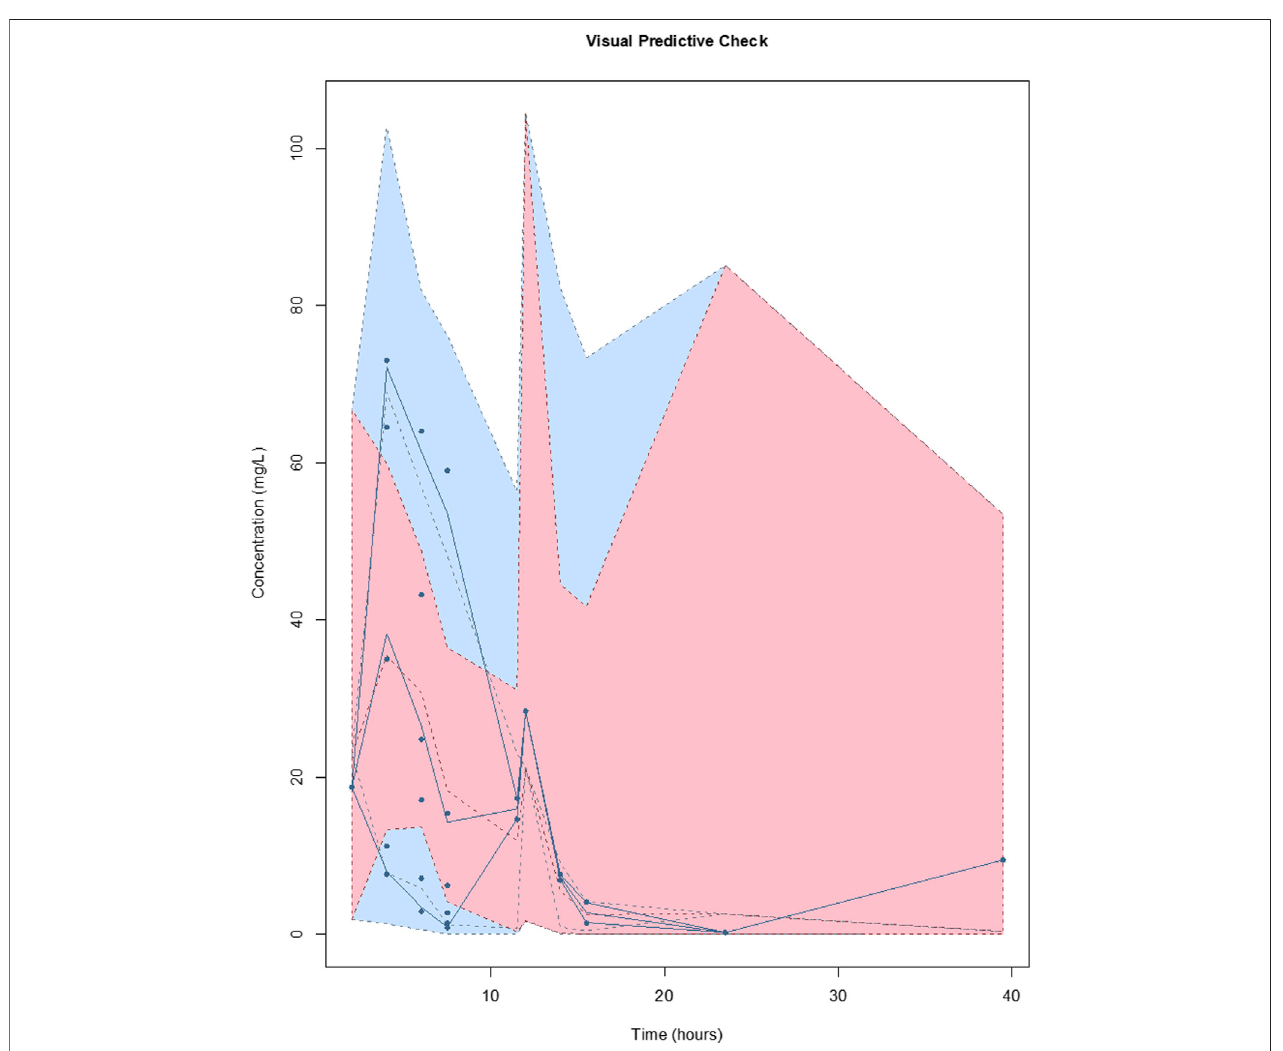
FIGURE2| Visualpredictivechecksofthe fi nalcovariatemodelformeropenem.Thelinesrepresentthepercentilesof1,000simulatedmeropenemconcentration- time pro fi les superimposed with observed meropenem concentrations (circles). The blue shading around the lines represents the 95% CI around each percentile. The distribution of the simulated concentration pro fi les is similar to that of the observed concentrations, with all of observed concentrations between 5th and 95th simulated percentiles, respectively, suggesting that the model describes the data adequately.